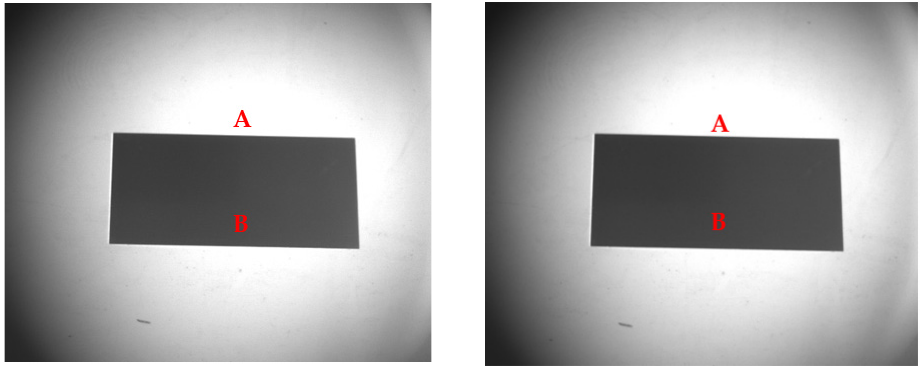
Figure 4. Image data at 532 nm visible band. ( Left ): the extinction ratio of the polarizer is 1000:1. ( Right ): the extinction ratio of the polarizer is 500:1. A is the background, B is the detection target (aluminum plates). Table 2. The SNR and relative error of each wavelength (different extinction ratios of polarizers).